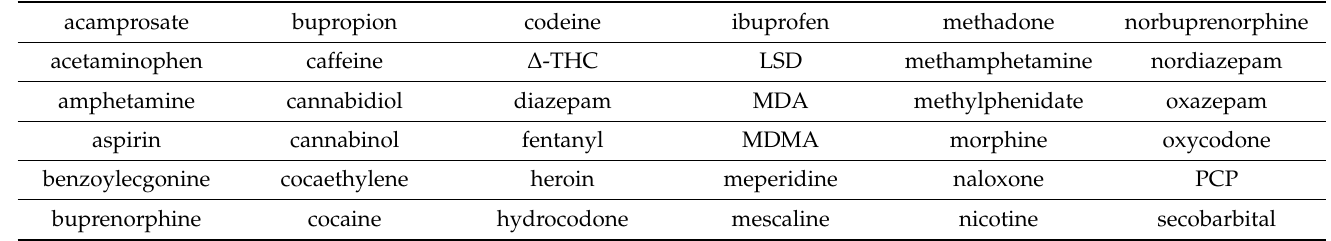
Table 2. List of 36 drugs included in the SERS library. All drugs were measured at 100 µ g/mL.